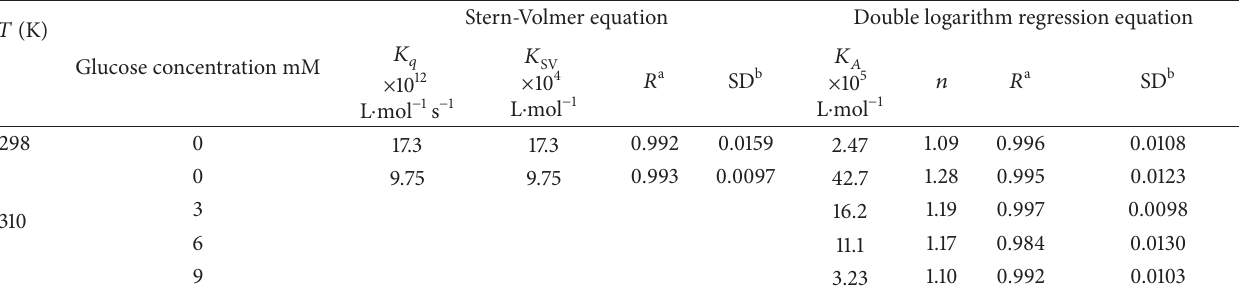
Table 1: Quenching rate constant of the bimolecule ( 𝐾 𝑞 ), quenching constant ( 𝐾 ( 𝑛 ) of Hyp to HAS.